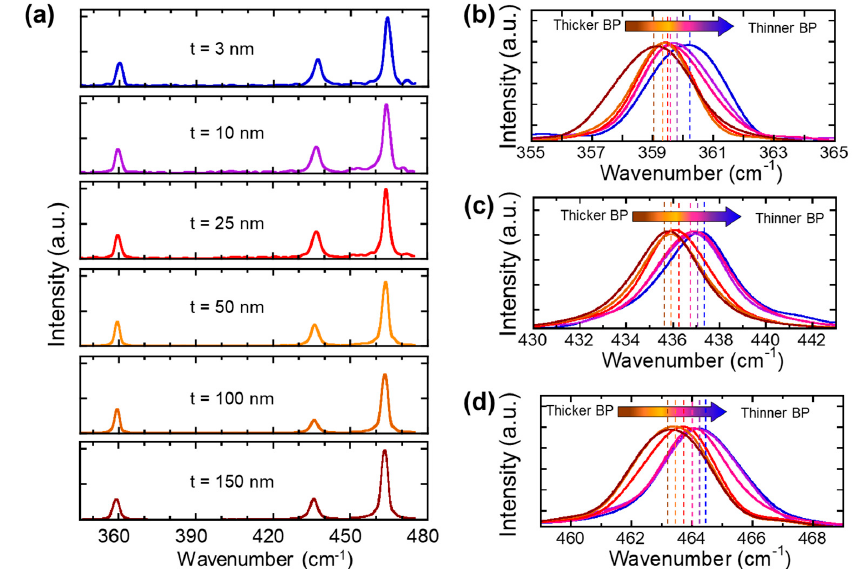
Figure 3. ( a ) Raman spectra of BP taken at different thicknesses from 150 nm to 3 nm. ( b – d ) Magnified Raman spectra of the A g1 , B 2g , and A g2 Raman modes as a function of their thickness.